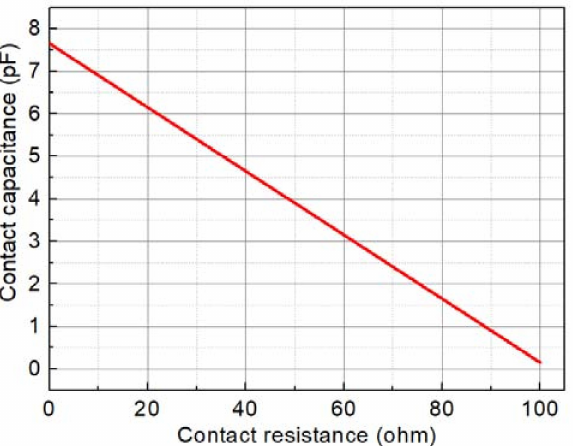
Figure 11. Relationship between the connection resistance R 1 and connection capacitance C 1 of the example connector. The function expression is C 1 = − 0.075 R 1 + 7.65. The unit of capacitance is pF and the unit of resistance is Ω .